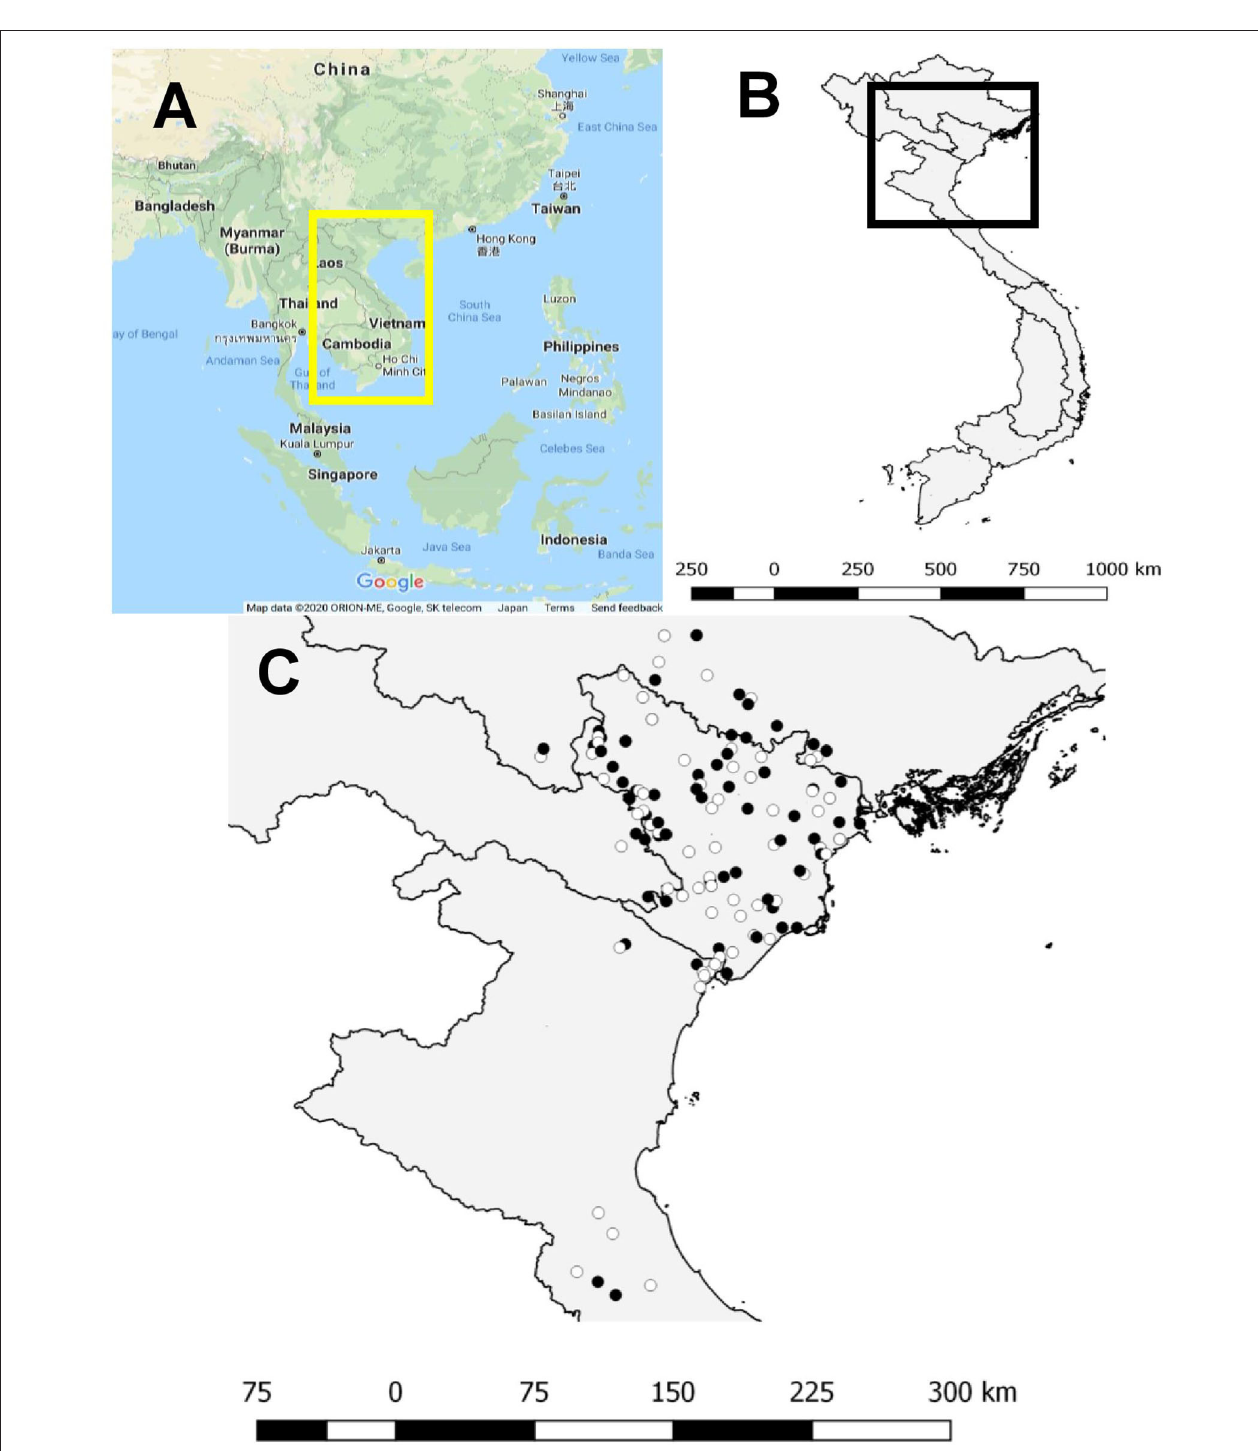
FIGURE 1 | Map of the study area. (A) Map is from Google Maps (Map data © 2020 Google) and the yellow rectangle shows Vietnam. (B) Map of Vietnam; black square indicates the study area. (C) Locations of the 187 pig farms in northern Vietnam involved in this study. Black dots indicate PEDV case farms and white dots indicate PEDV control farms. Geographical locations of the farms were mapped with the Quantum Geographic Information System.